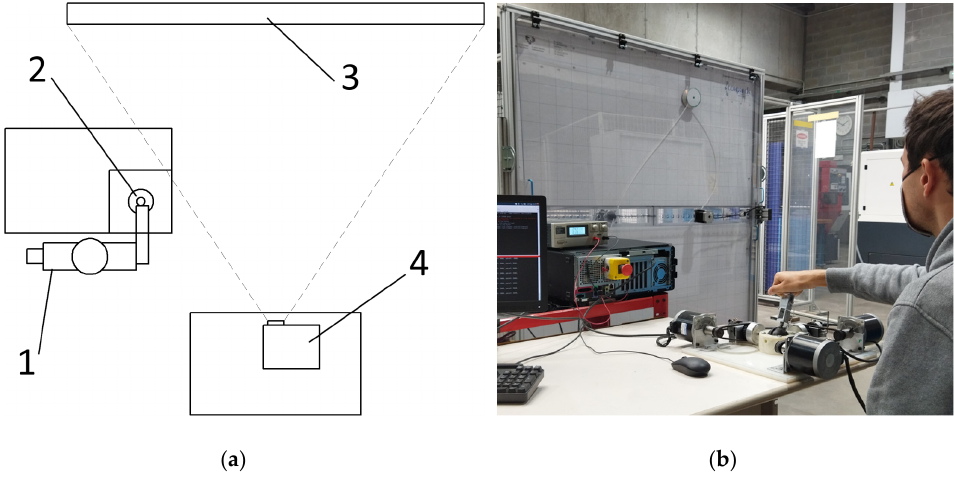
Figure 2. The experimental setup: ( a ) schematic representation (view from the top): 1 operator, 2 haptic device, 3 parallel manipulator, 4 projector; ( b ) real implementation (projector is turned off).